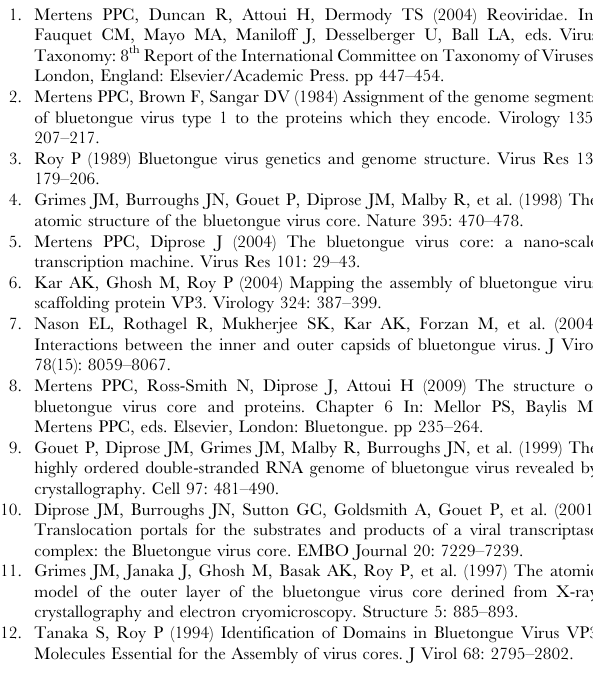
Figure S3 Phylogenetic tree inferred with maximum likelihood analysis using the 3 9 region of BTV Seg-3 (nucleotides 1779 to 2648) and the GTR + I + C model. The viruses included are indicated in tables 1 and 2. Isolate abbreviations: Serotype/origin